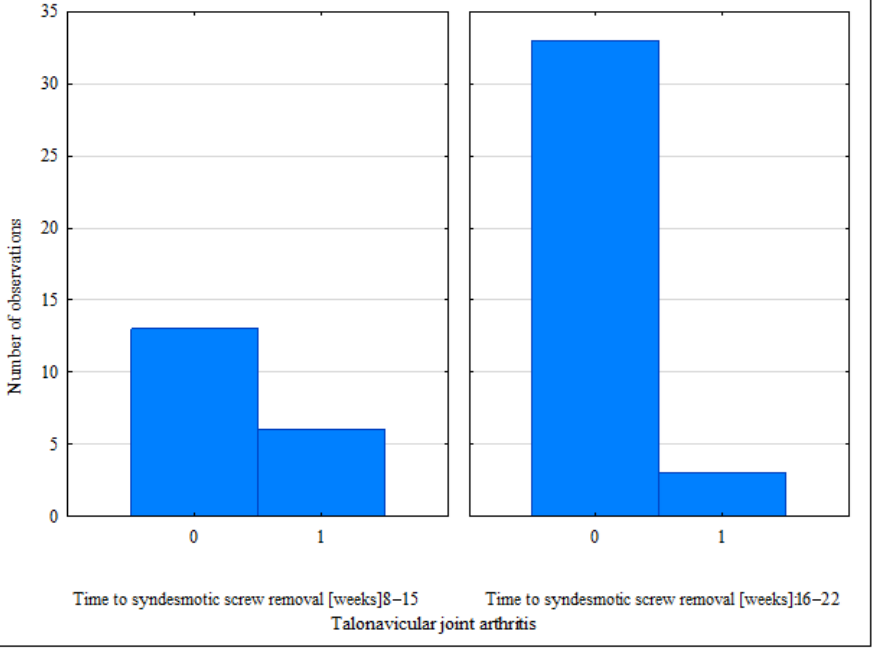
Figure 3. Talonavicular joint arthritis at the final follow-up in the 8 – 15 and 16 – 22-week